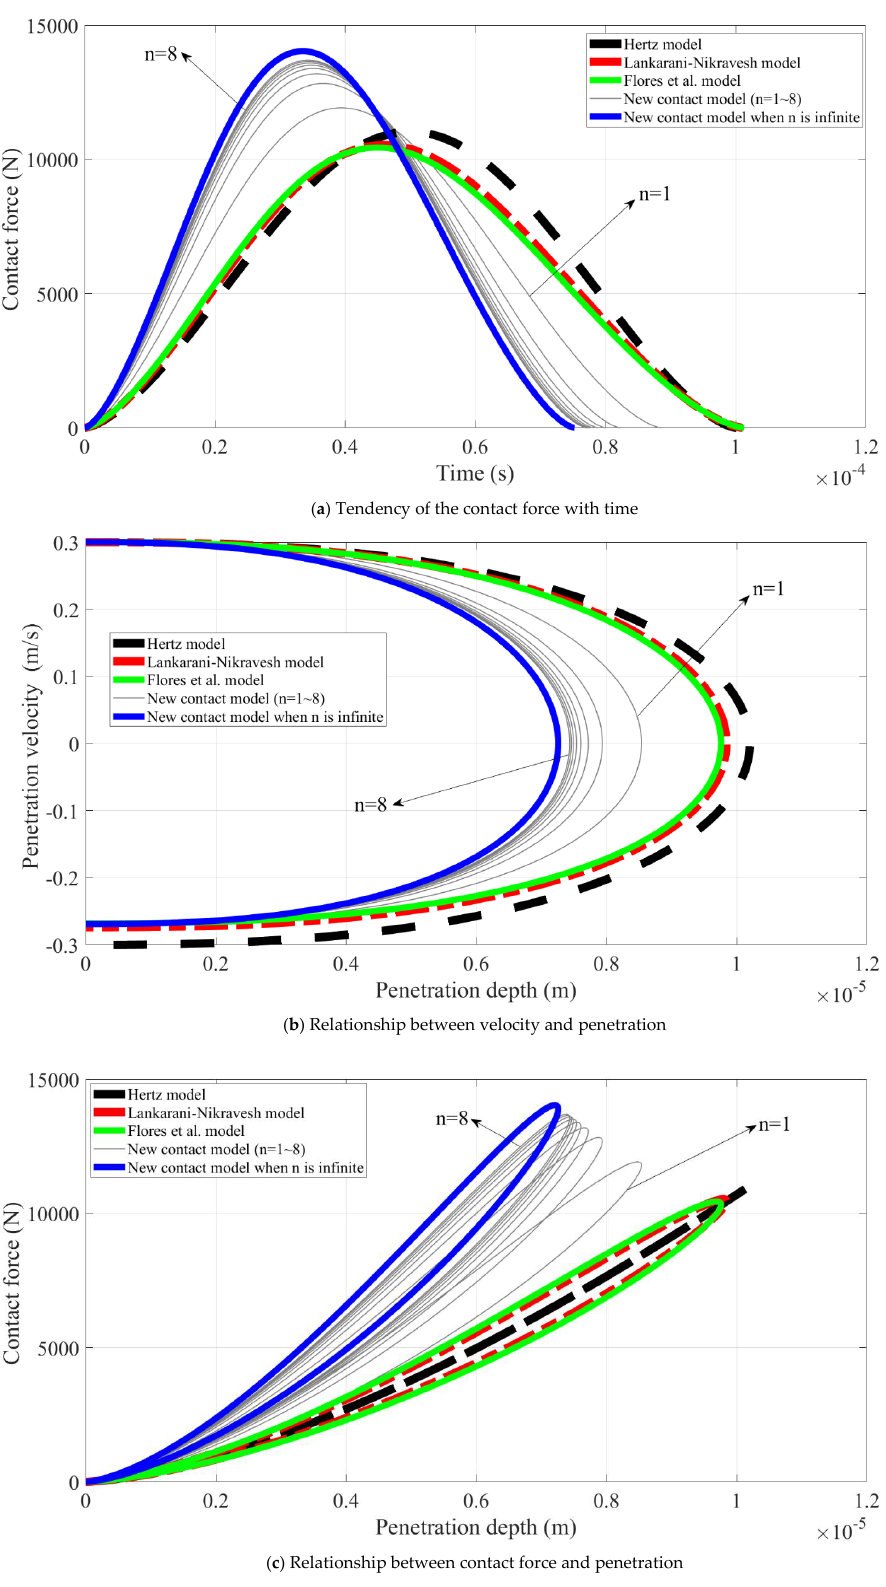
Figure 9. Comparison analysis between the existing contact models and the proposed contact model.